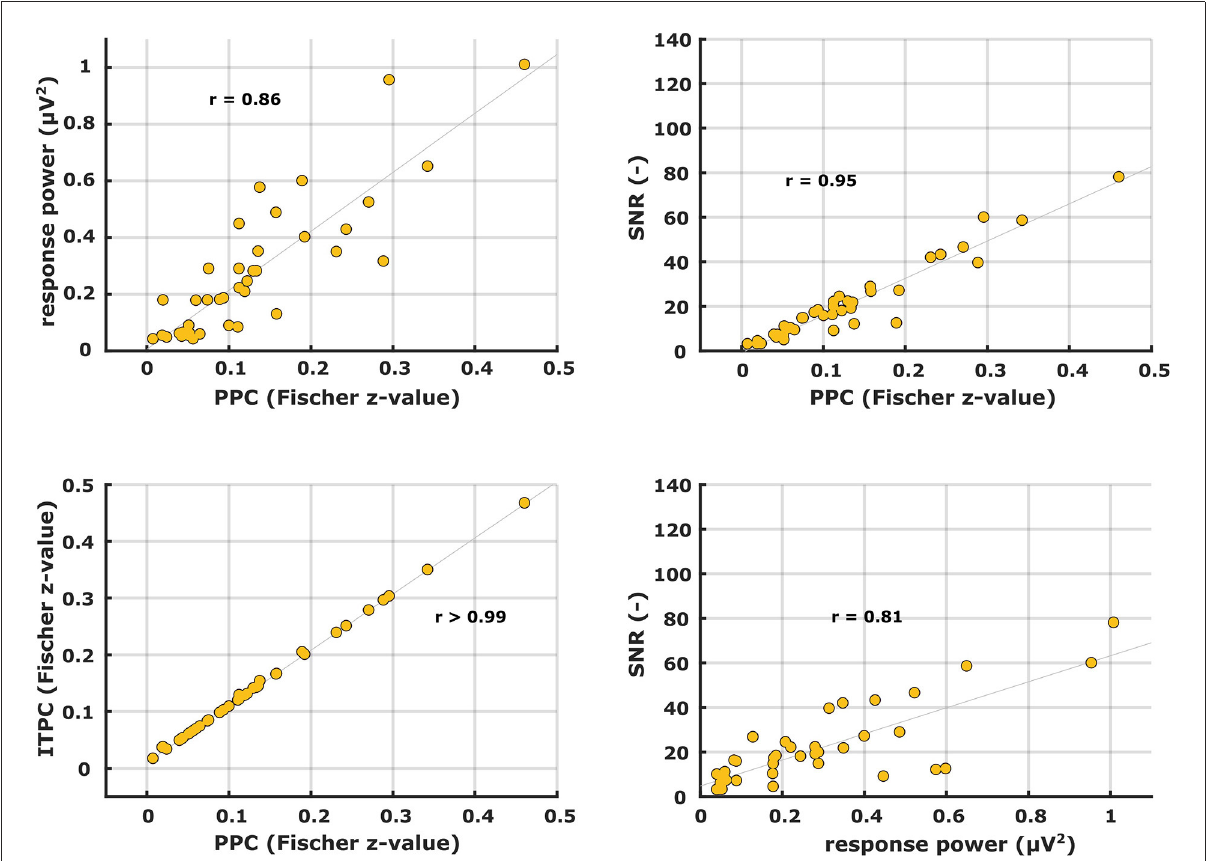
FIGURE5 Scatter plots between different ASSR electrophysiological metrics for syllabic-like stimuli in the left hemispheric channel.